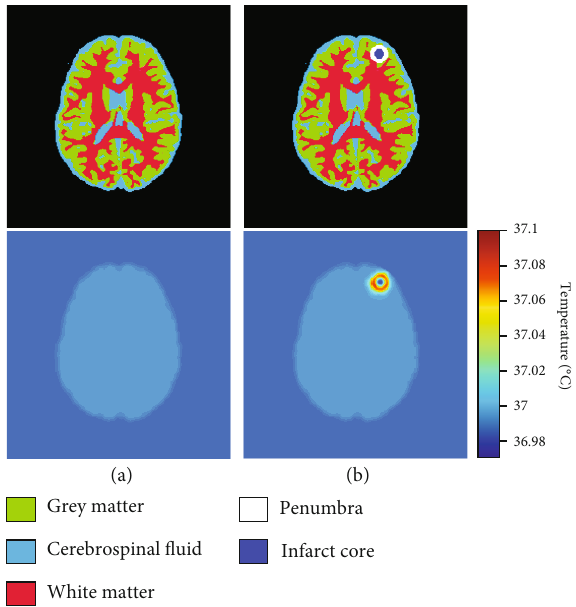
Figure 3: Calculated temperature distribution of brain with circular acute ischemic stroke lesion using Pennes bioheat equation. (a) Brain without acute ischemic stroke. (b) Brain with acute ischemic stroke lesion of spherical infarct core of 10mm of diameter, surrounded by penumbra with 5 mm thick.